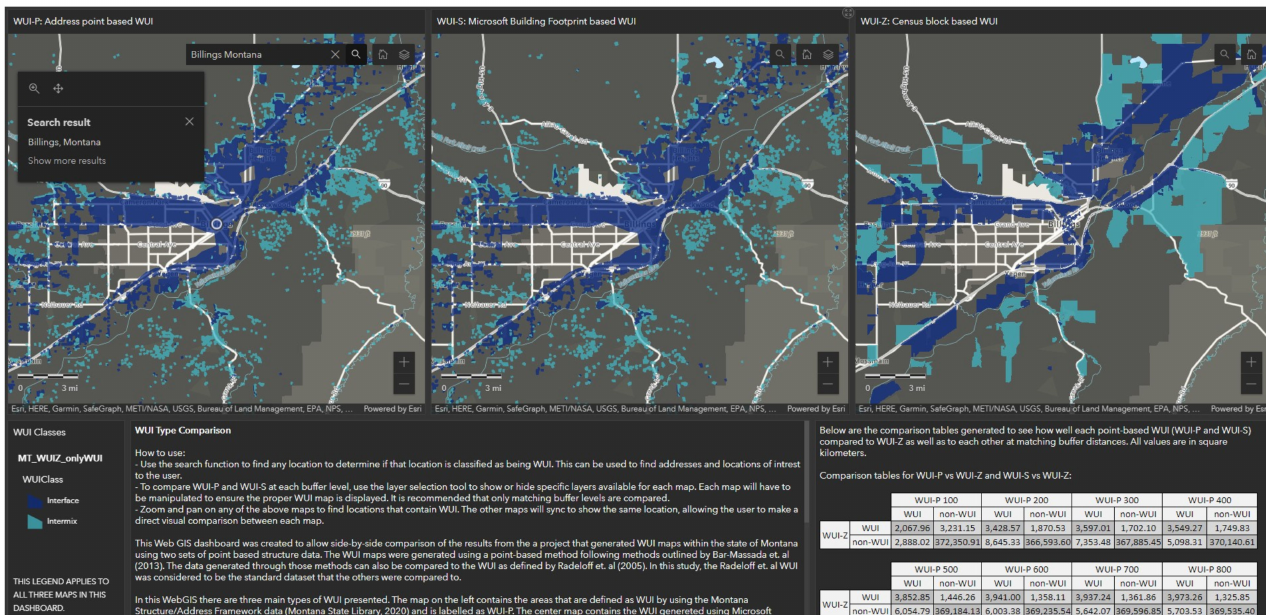
Figure 10. The WUI in Billings, Montana in the web GIS